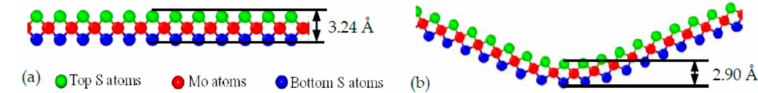
Figure 5. The atomic structures of SLMoS2 nanosheets in the process of nanoindentation: ( a ) before loading; ( b ) after